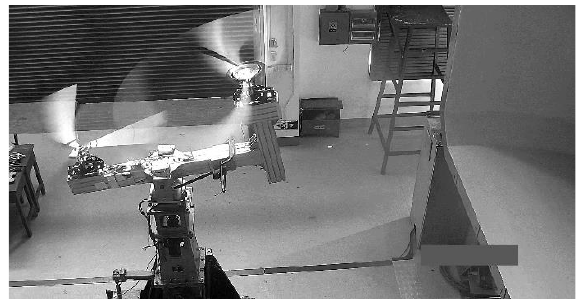
Figure 5. Tandem rotor test of autorotation in forward flight.